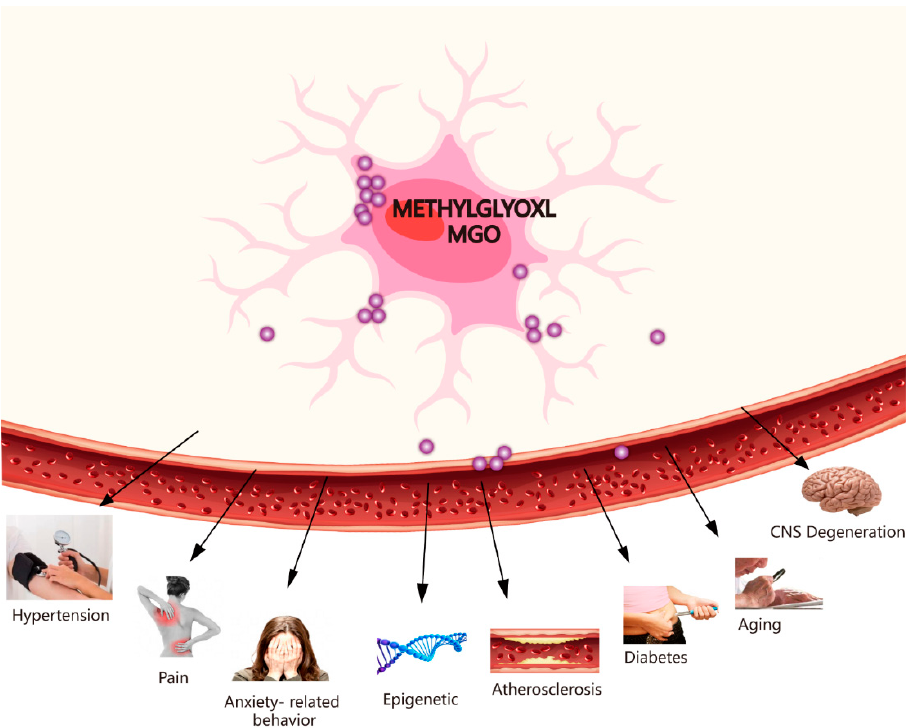
Figure 3. MGO-induced diseases. MGO-induced diseases involve hypertension, pain, anxiety-related behaviour, epigenetic, atherosclerosis, diabetes, ageing, and CNS degeneration.